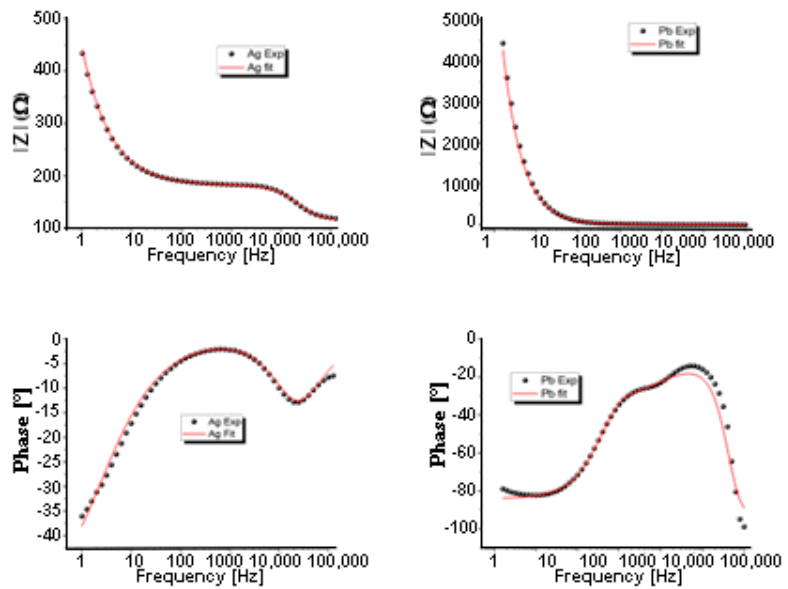
Figure 5. Bode plots: scatter points present the experimental magnitude Bode plot and phase angle Bode plot for lead and silver. Red line represents their best fit based on the equivalent circuit shown in Figure 4.